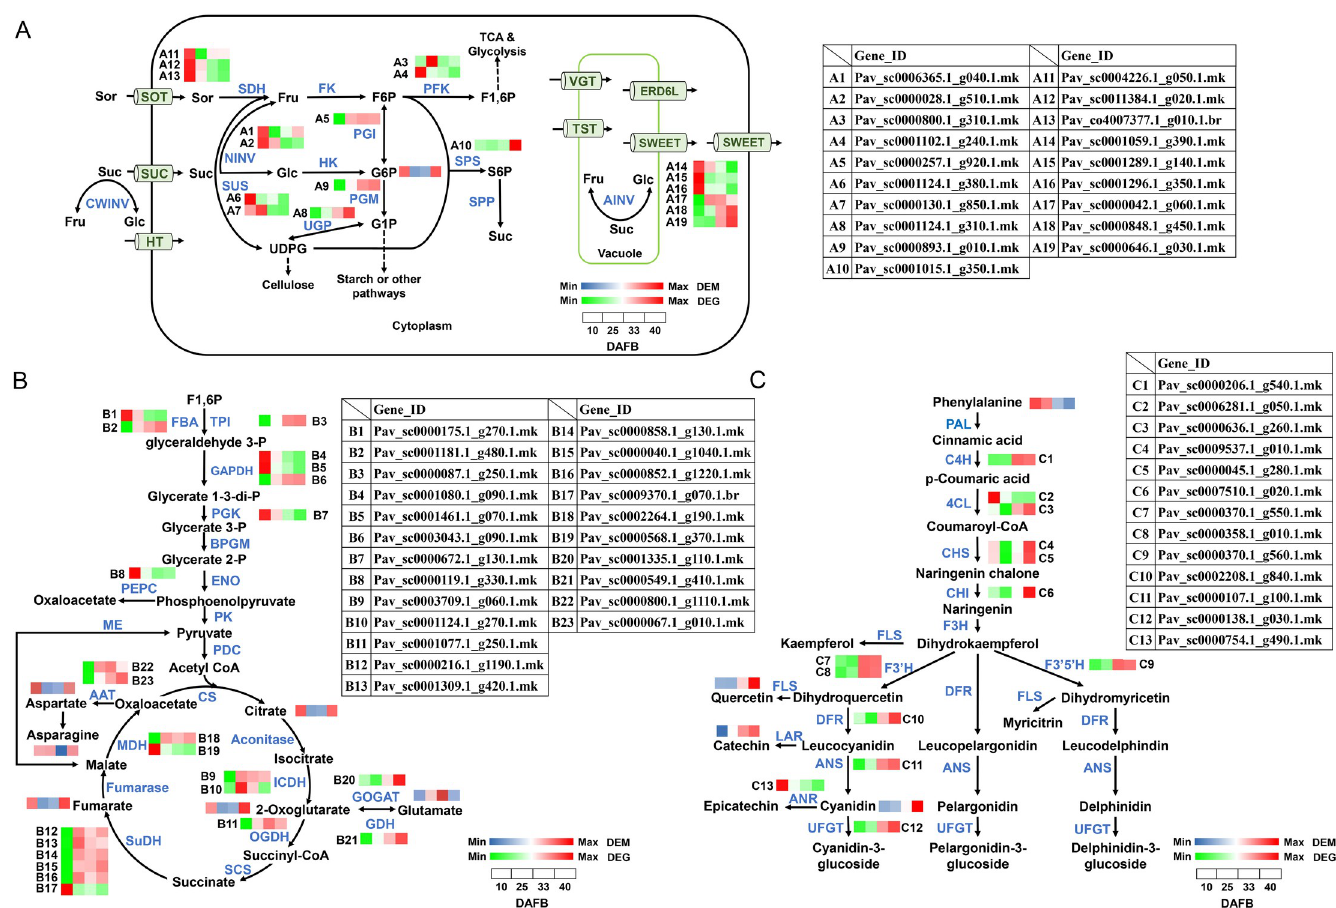
Fig 6. Expression profiles of DEGs and DEMs associated with (A) sugar metabolism, (B) organic acid metabolism, and (C) flavonoid